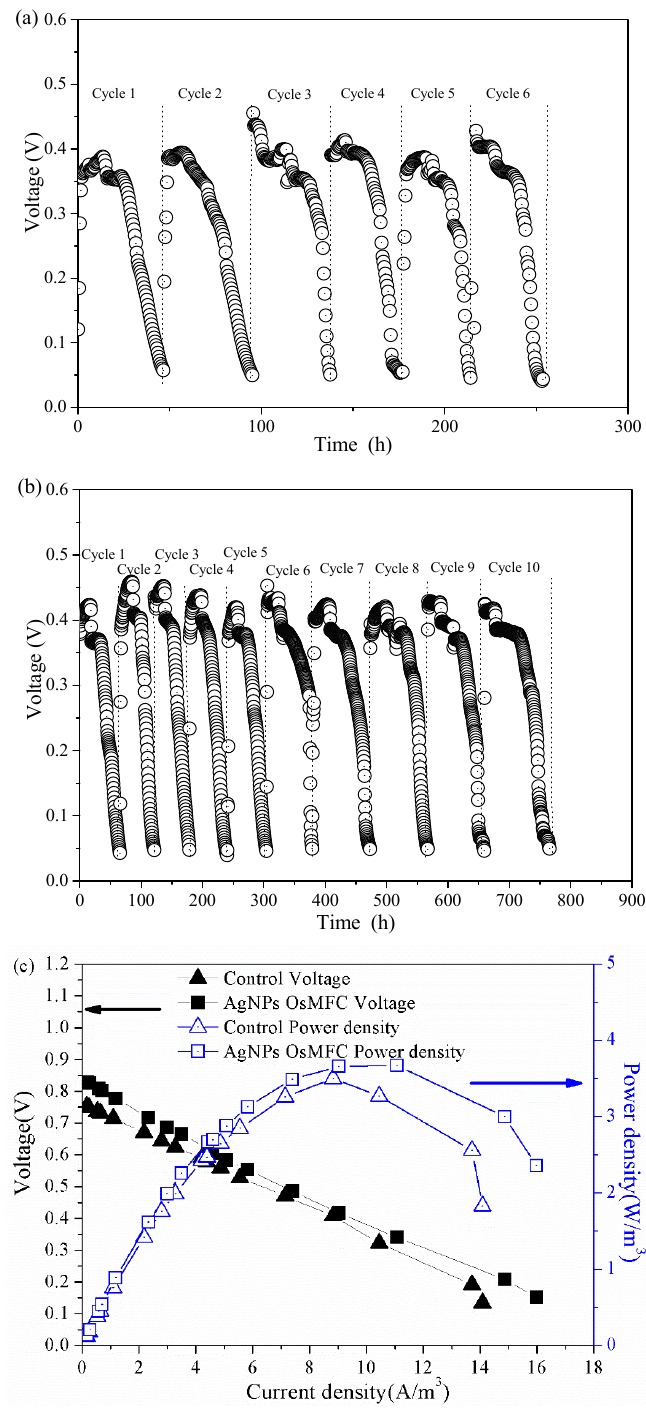
Figure 3. Electricity generation of ( a ) the control OsMFC and ( b ) AgNP-OsMFC, and ( c ) their power density and polarization curves.